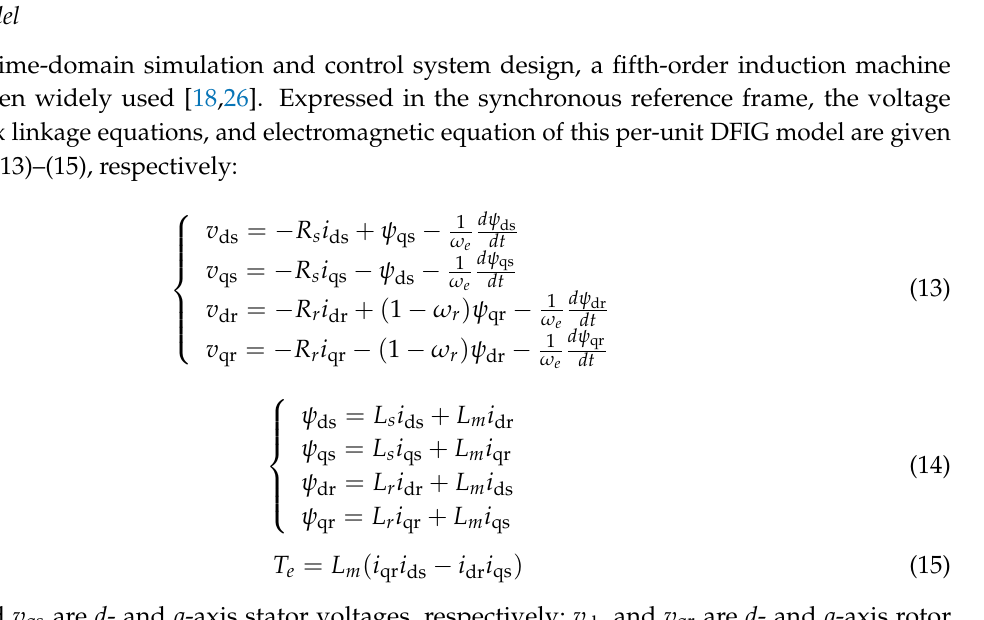
Figure 3. Block diagrams of the hydrogen supply system model including solenoid values, pressure tanks, and gas compressor.